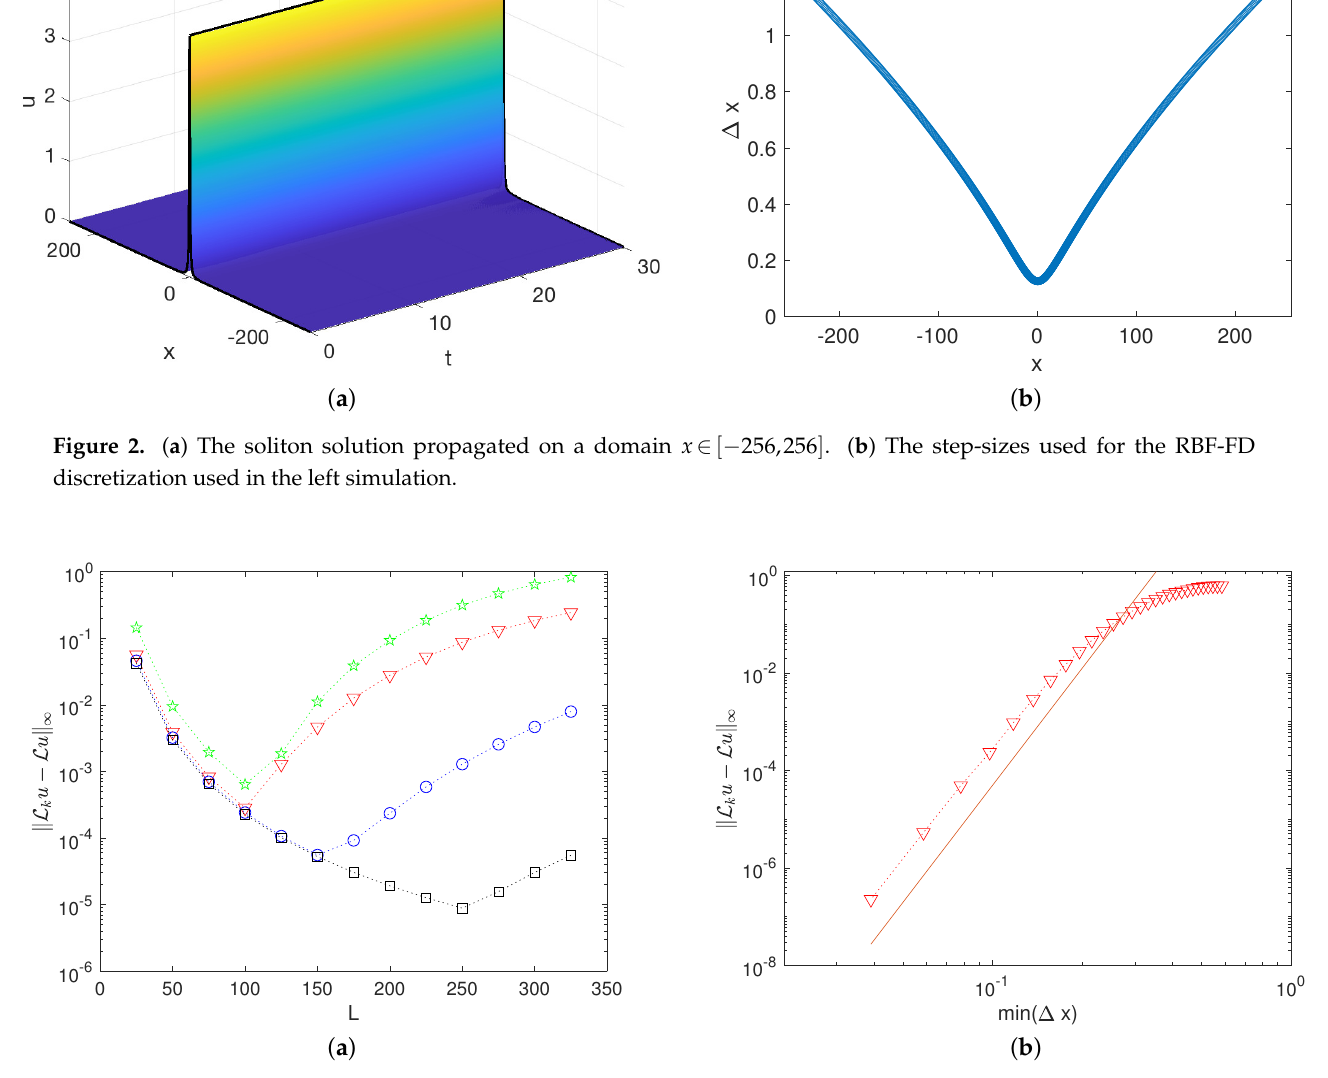
Figure 3. The infinity norm of the error of the numerical approximation of the linear operator, L N u , against the exact L u on the solitary wave u ( x )= 4/ ( 1 + x 2 ) is depicted. ( a ) The error’s dependence on domain size, L , is compared for the RBF-FD discretization using the spatial points in (3) with a = 2 (red triangles), a = 3 (blue circles), and a = 3.5 (black squares), and an equi-spaced Fourier discretization (green stars). All of these computations use N = 512. ( b ) The error dependence on the minimal step size for N = 1024, L = 800, altering the step size with the parameter “ a ”. The numerical results are marked with triangles; the continuous line marks O ( ∆ x 8 )